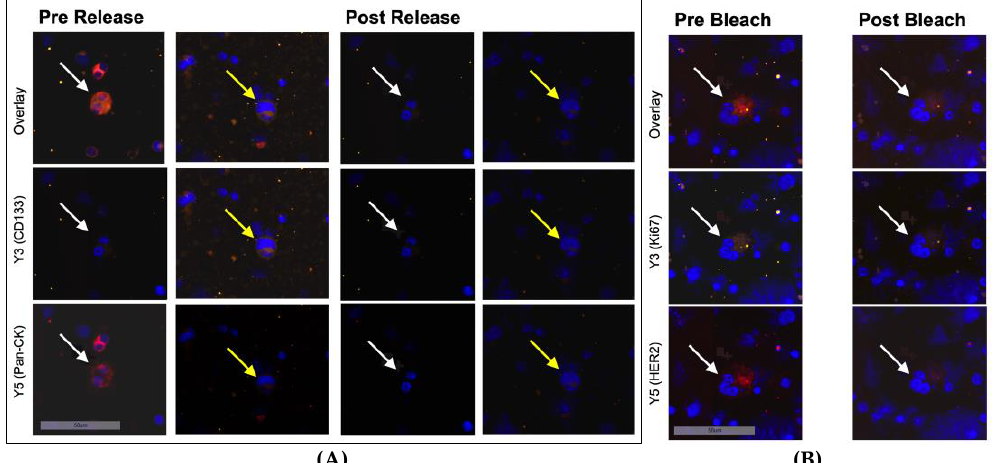
Figure 2. Immunofluorescent staining of ZR75-1 cells (white arrows) and T98G cells (yellow arrows) mixed with bone marrow cells at 20-fold magnification. ( A ) Before and after treatment with the releasing enzyme. Hence, secondary fluorescence of Pan-CK was successfully quenched and another set of antibodies could be applied. ( B ) Before and after bleaching with increased light exposure in channels Y3 and Y5. Shown is a loss of the secondary fluorescent activity of markers Ki67 and HER2 to prepare the sample for another set of antibodies.